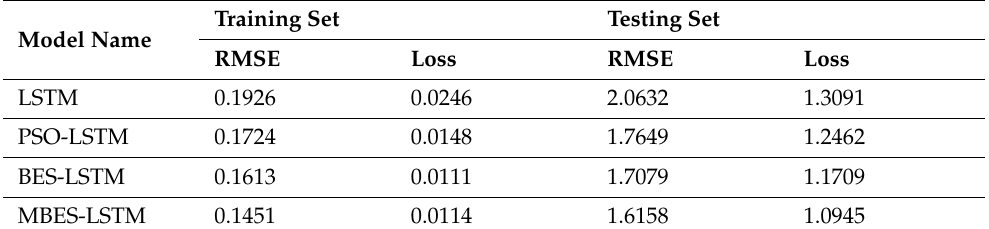
Table 9. Forecasting errors of LSTM, PSO-LSTM, BES-LSTM, and MBES-LSTM models.